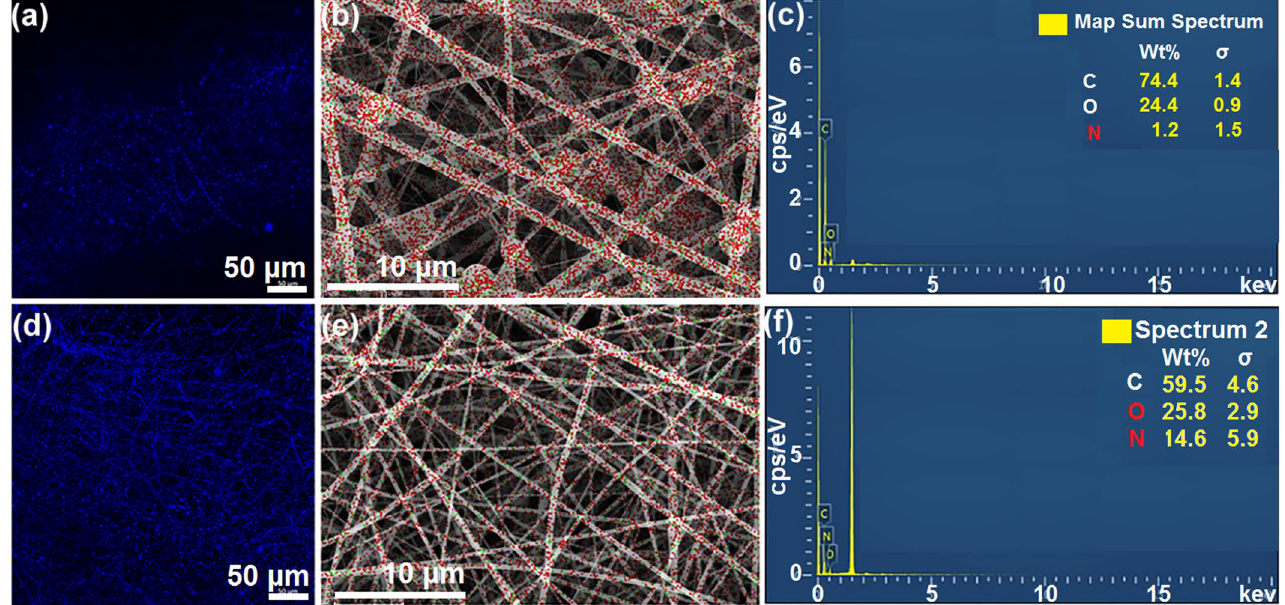
Figure 5. Fiber membrane fluorescence photo and EDS energy spectrum: ( a ) WSL fluorescence photo in core–sheath structure fiber membrane F1; ( b , c ) N element energy spectrum in core–sheath fiber membrane F1; ( d ) WSL fluorescence photo in core–sheath layer of hybrid fiber membrane F2; ( e , f ) N element energy spectrum in the whole hybrid fiber membrane F2.